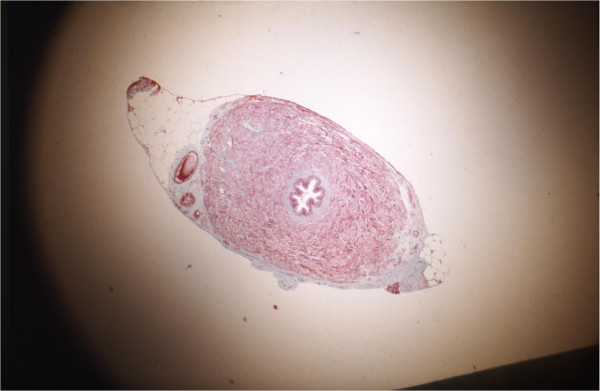
Normal vas deferens.